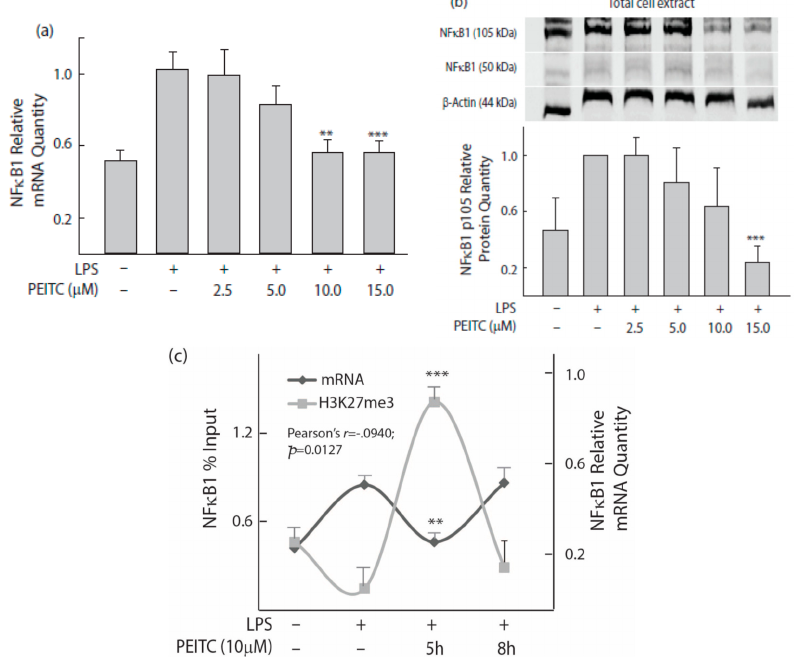
Figure 3. PEITC concentration- and time-dependent NF κ B1 suppression in colon epithelial cells. ( a ) The relative NF κ B1 mRNA quantity in the treated cells. Cells were treated with PEITC for 5 h before adding LPS for an additional 4 h incubation. Negative control cells did not receive any treatment, while positive control cells received LPS stimulation only. GAPDH was used as an internal control for mRNA expression. Values are mean ± SEM ( n = 6); ( b ) Immunoblot analyses showing suppression NF κ B1 in response to PEITC treatments. Expression levels were normalized to β -actin. Values are expressed as means ± SEM ( n = 3) of three separate experiments; ( c ) Effect of PEITC (10 μ M) treatment on NF κ B1 mRNA levels and on H3K27me3 methylation state in a time-dependent manner. Histone H3 methylation changes on NF κ B1 promoter were measured by chromatin immunoprecipitation using an anti-H3K27me3 antibody and followed by qPCR. Data points represent the average % input ± SEM ( n = 3) from each experiment. ** p < 0.01, *** p < 0.001 compared with positive